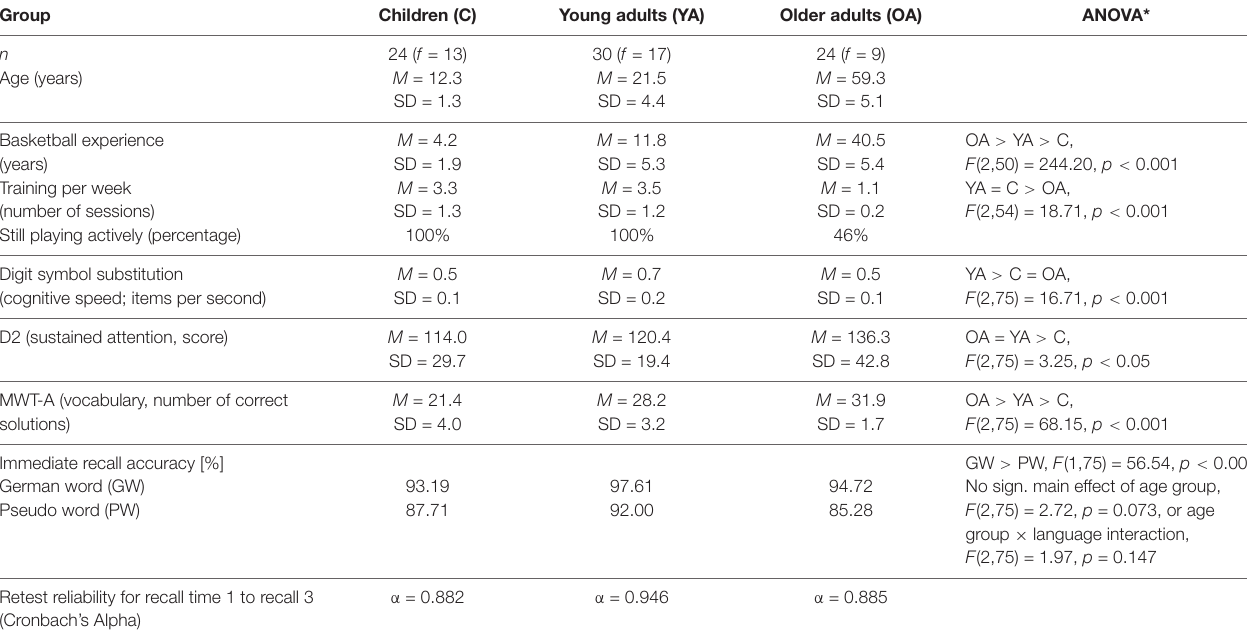
TABLE 1 | Descriptives, cognitive background information, and reliability of the vocabulary learning task. Group